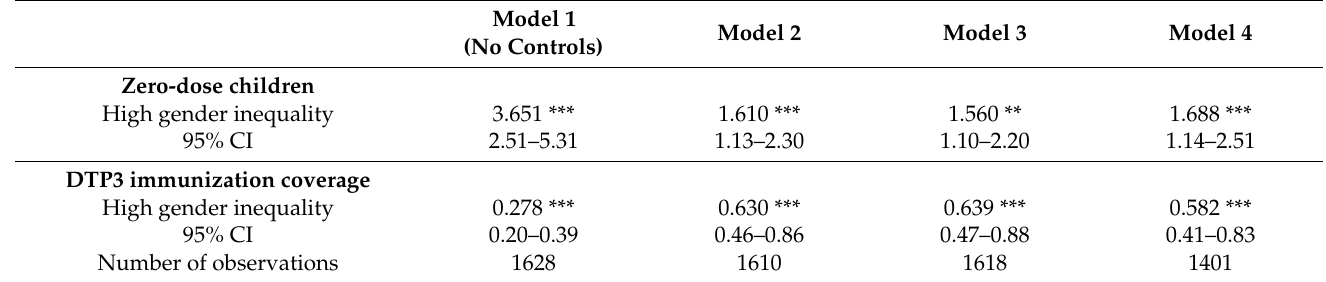
Table 3. Odds ratios for zero dose DTP and DTP3 immunization coverage according to GDI category (up to 165 countries,